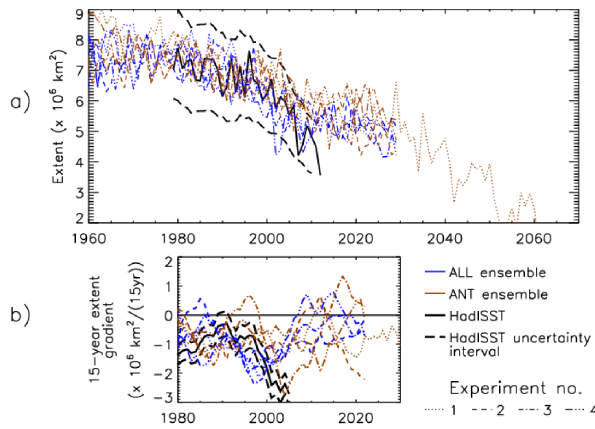
Fig. 1. (a) Arctic September mean sea ice extent in the HadGEM1 historical forcing runs and (b) 15-yr running gradient of extent. Table 1. Statistics of September ice extent time series in the ALL & ANT ensembles and in HadISST observations, from 1979–2012. All values are in millions of square